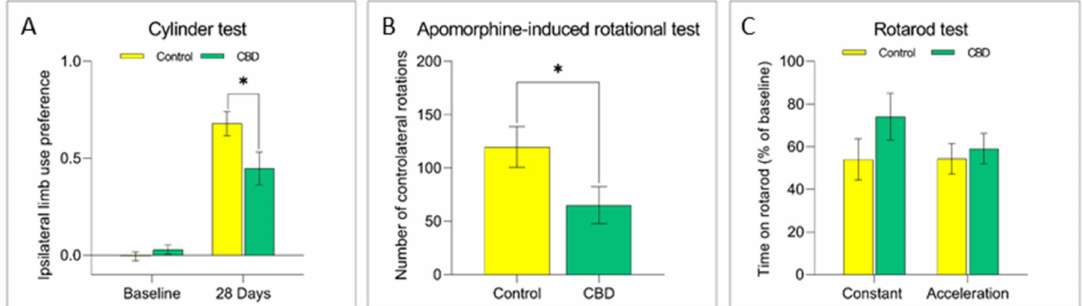
Figure 2. Effects of chronic treatment with CBD on motor behavior of 6-OHDA lesioned rats. The graphs show the motor performance evaluated using the ( A ) Cylinder, ( B ) Apomorphine-induced rotational and ( C ) Rotarod test in both experimental groups. Results are expressed as mean ± SEM. * p < 0.05 vs. control t = 2218, df = 39 (Cylinder), t = 2109, df = 28 (Apomorphine), Student’s t -test unpaired two-tailed. N = 9 to 20 in each